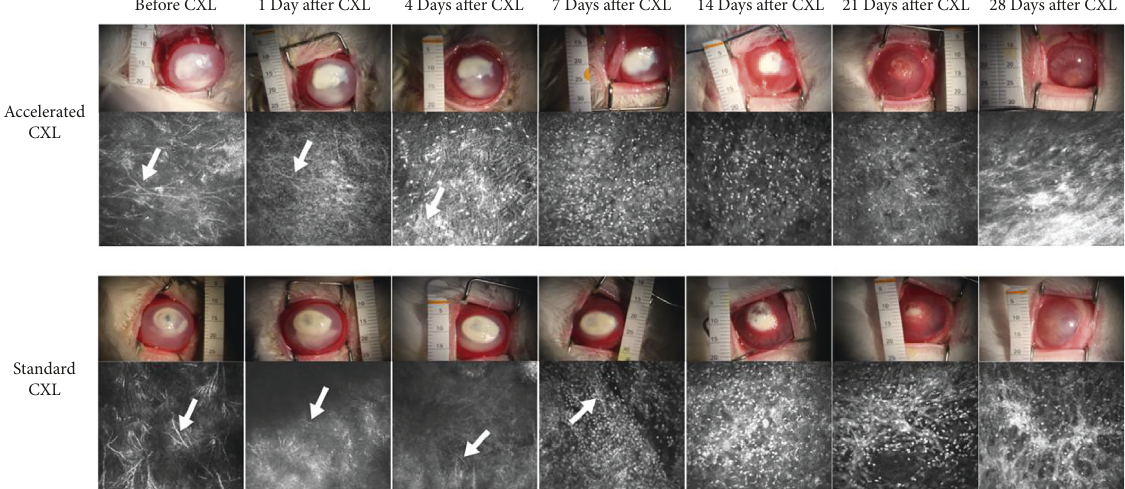
Figure 1: Representative images of the corneal ulcer of a representative rabbit and its corresponding IVCM in each group at all follow-up periods. The white arrow shows the fungal hypha. CXL, standard corneal collagen